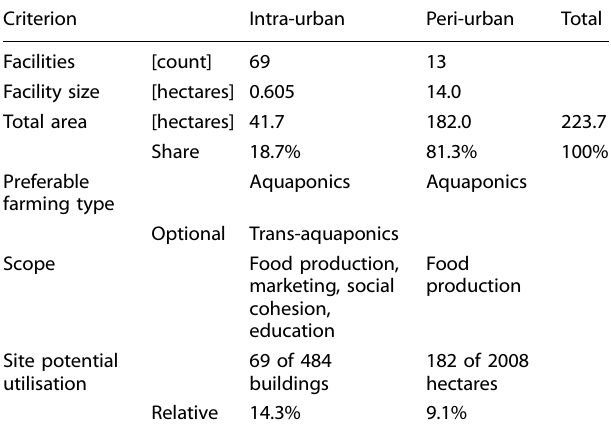
Table 4. Berlin/hinterland aquaponic farming